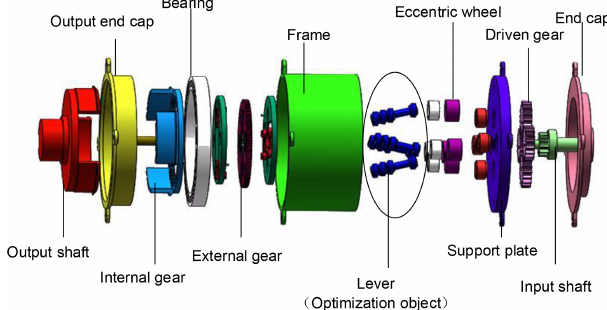
Figure 1. Exploded view of the overall structure of the